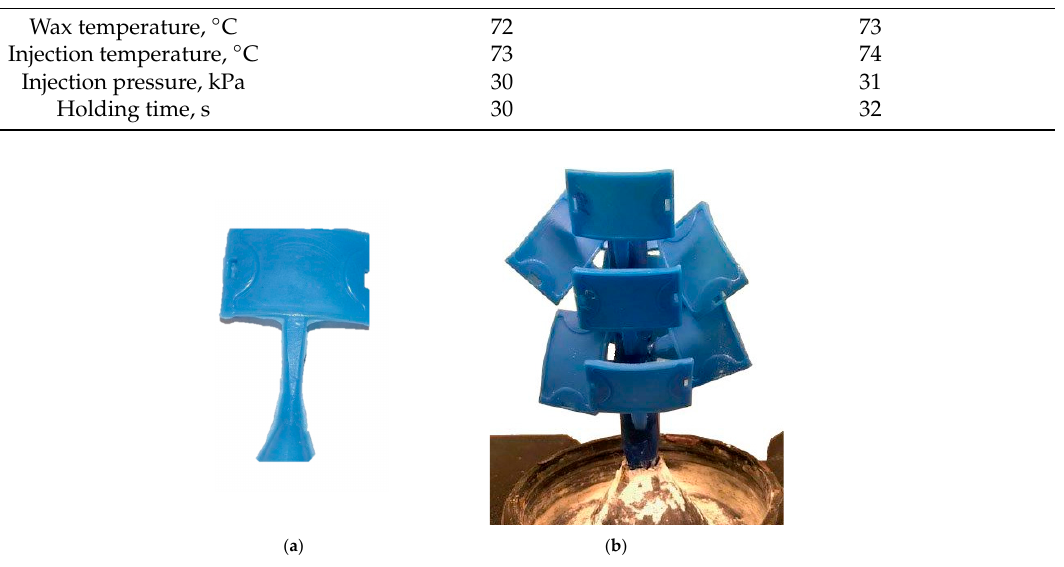
Table 4. The injection process parameters of pure wax and wax/BNT blends.